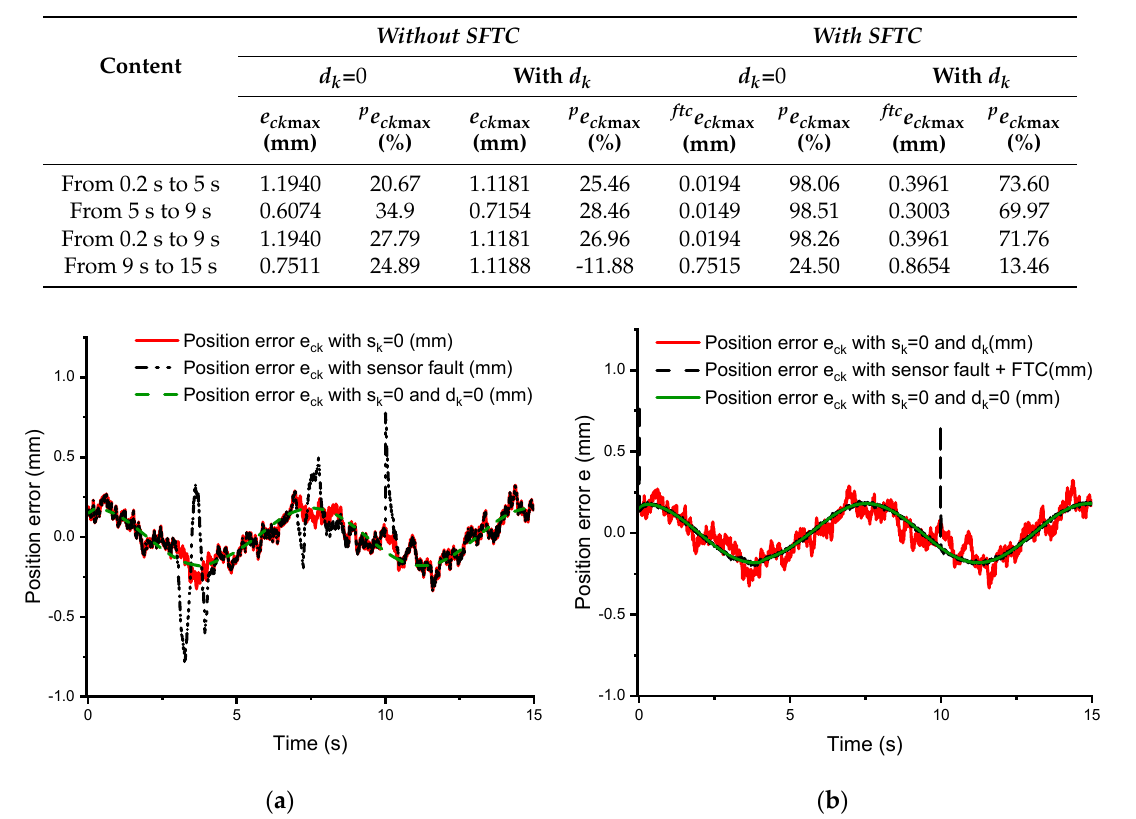
d of ( a ) without SFTC, and ( b ) with SFTC. Figure 8. The position control error e ck with disturbance d k of ( a ) without SFTC, and ( b ) with k